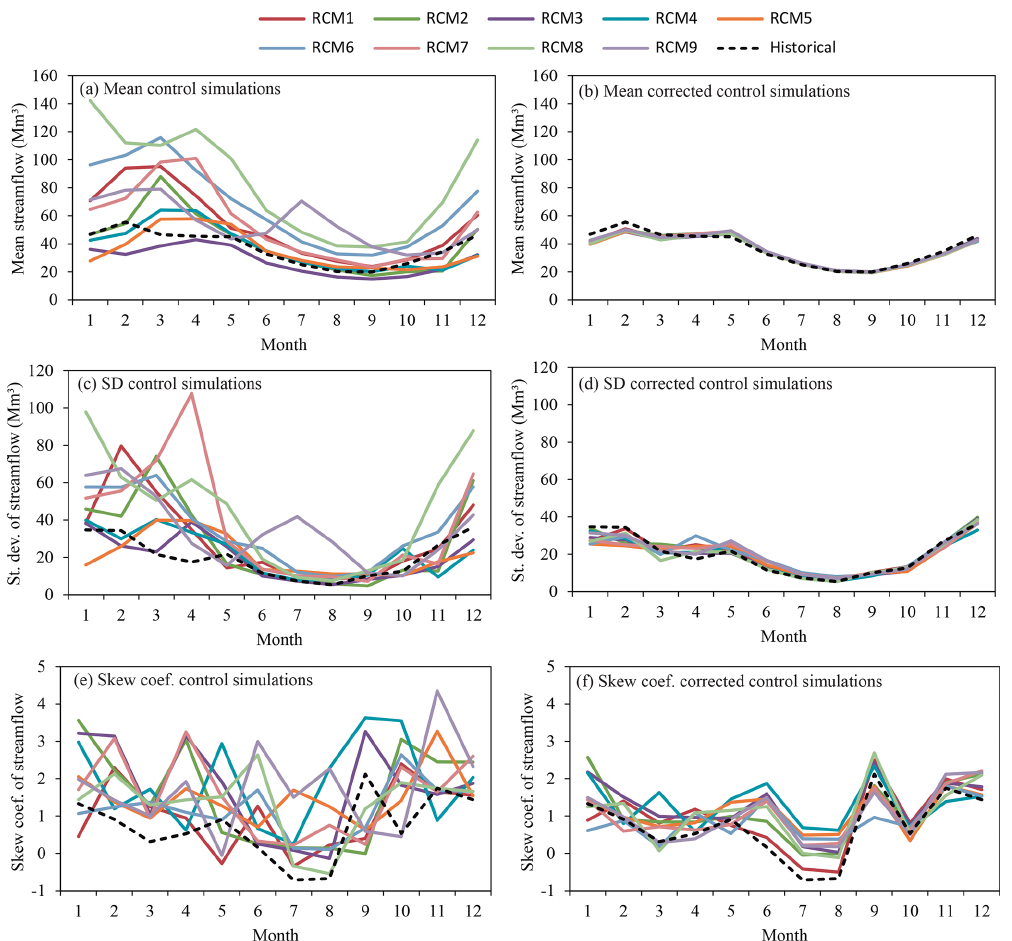
Figure 7. Monthly mean, standard deviation and skew coefficient of streamflow within the mean year of the period (1972–2001) for the historical and control simulation series (a, c, e) and historical and corrected control simulation series (b, d, f)